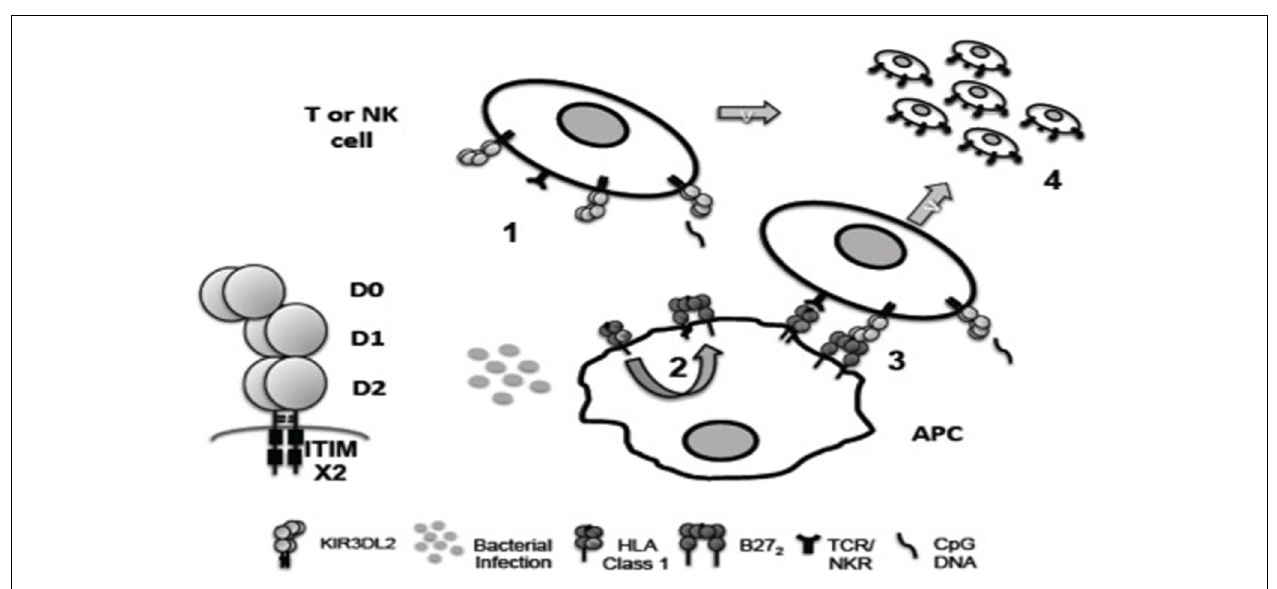
could bind more strongly to KIR3DL2 than β 2m-associated HLA class 1. B27 FHC are predicted to bind to KIR3DL2 via the D0 domain. (4) KIR3DL2 binding to ligand inhibits activation induced cell death driven byTCR/NK receptor ligand interactions, promoting the survival of pathogenicTh17 and NK cell subsets in disease.The D0 domain of KIR3DL2 also binds bacterial CpG DNA. CpG DNA internalized by KIR3DL2 could costimulate NK andT cell viaTLR9 ligation (1 and